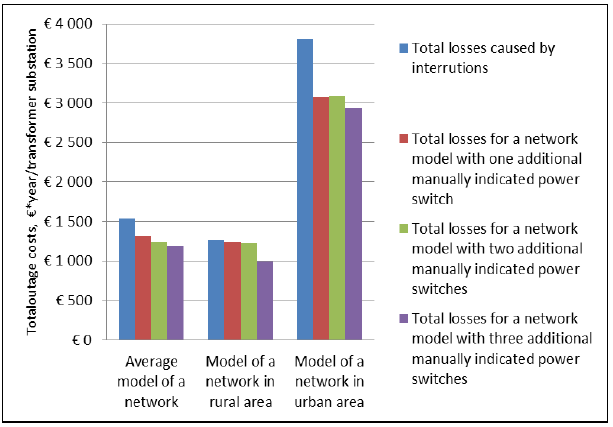
Fig. 7. The total losses resulting from